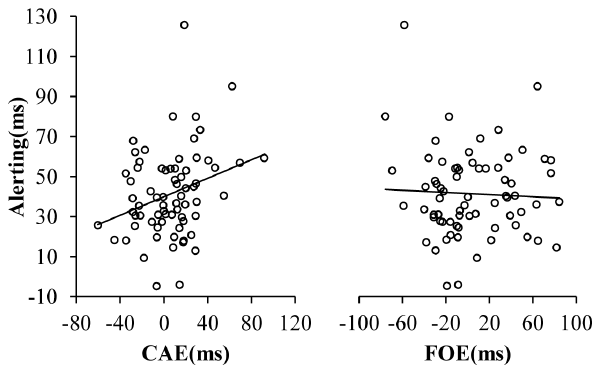
Figure 4. Scatter distribution in experiment 2. Curve fit between the efficiency of alertness and the CAE, alertness and the FOE, alertness and the congruency effect. NB. CAE = conflict adaptation effect on the change trials; FOE = feature overlap effect on the iI trials.